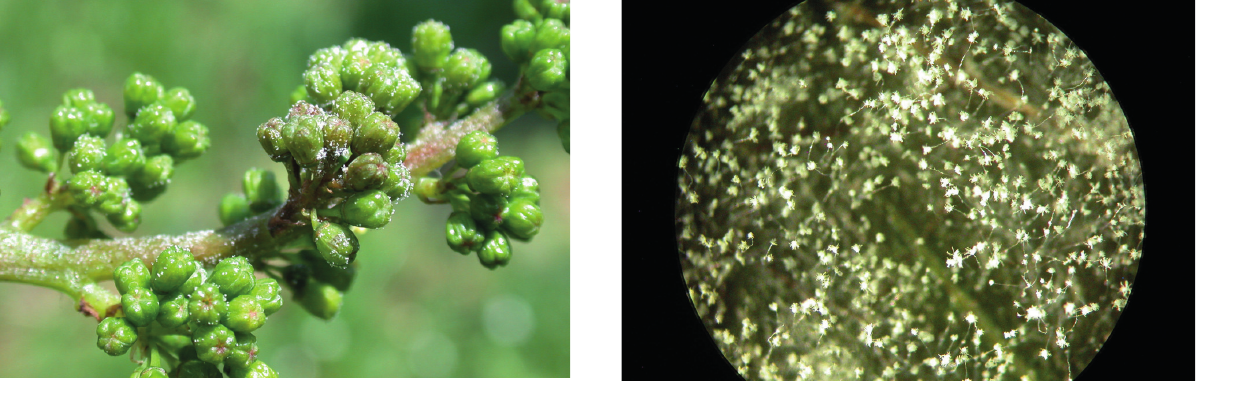
Figure 5. Sporulation on a grape cluster before bloom. Figure 6. Sporangiophores and sporangia of Plasmopara viticola .